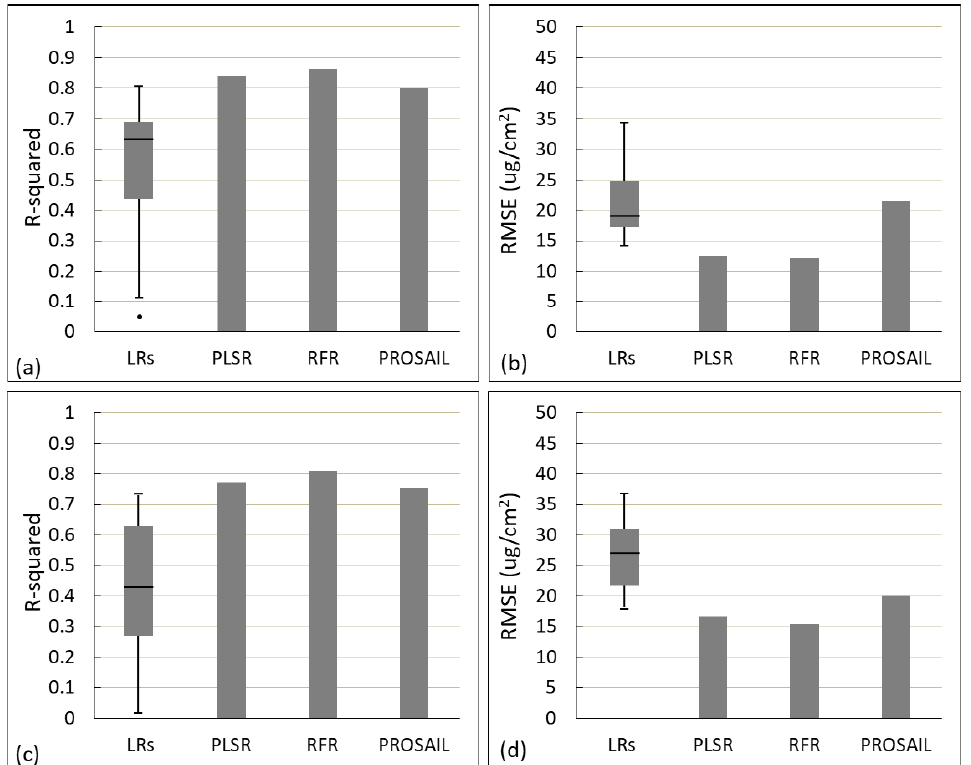
Figure 8. Validation results of the four selected models. Figure ( a , b ) are for the models with the June image, ( c , d ) are with the August image. LRs include 39 simple linear regressions built with each individual predictor variable.